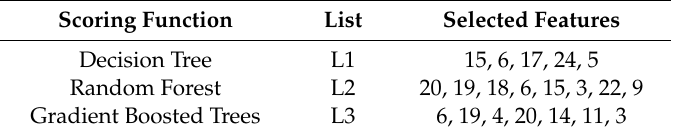
Table 8. Selected features by individual scoring functions.